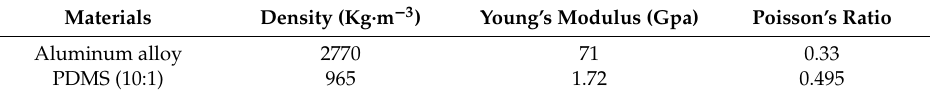
Table 1. Material parameters of soft mold simulation.